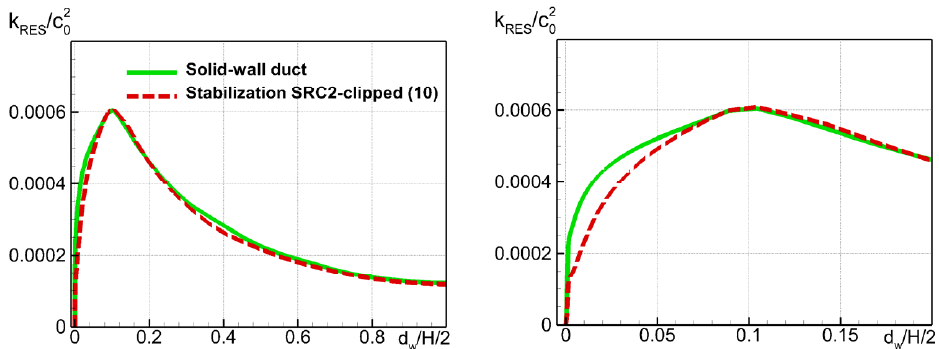
Figure 15. Comparison of wall-normal profiles of resolved TKE at x = 0.6 m predicted for solid-wall duct using original governing equations and for lined duct using equations with added clipped stabilizing body force SRC2 (10).